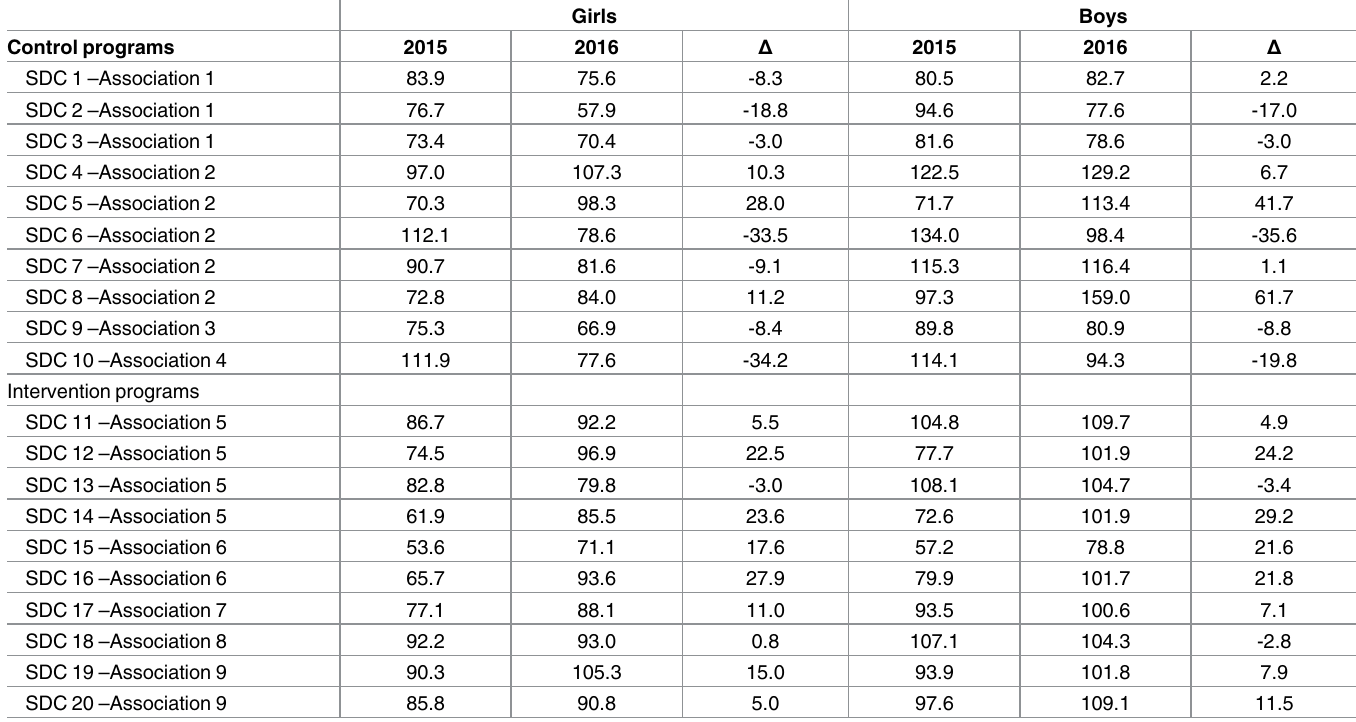
Table 3. Individual SDC